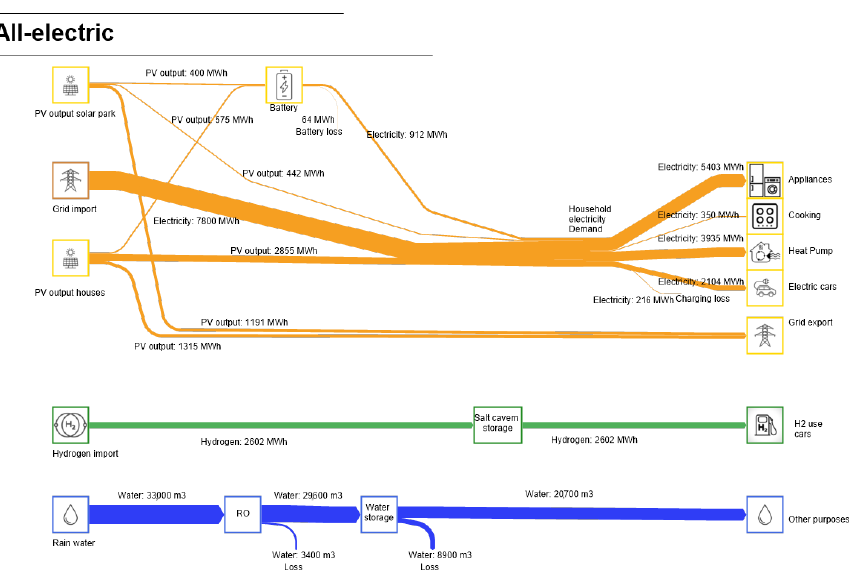
Figure 7. Sankey diagram of the yearly energy and water flows in the all-electric system. Electricity, hydrogen and water are three separate flows without integration. The households solely use electricity as their energy source. Part of their electricity demand (3297 MWh or 27%) is fulfilled by local PV, 7800 MWh or 65% by import from the grid and 912 MWh or 8% by local battery storage. Not all locally produced electricity can be stored in the battery or used directly, which results in 2506 MWh of electricity export to the grid. Losses for electricity conversion will be a few percentage points and are not shown in the Sankey diagrams. This will be done in a later stage of the system design and need to include DC/DC conversion as well.